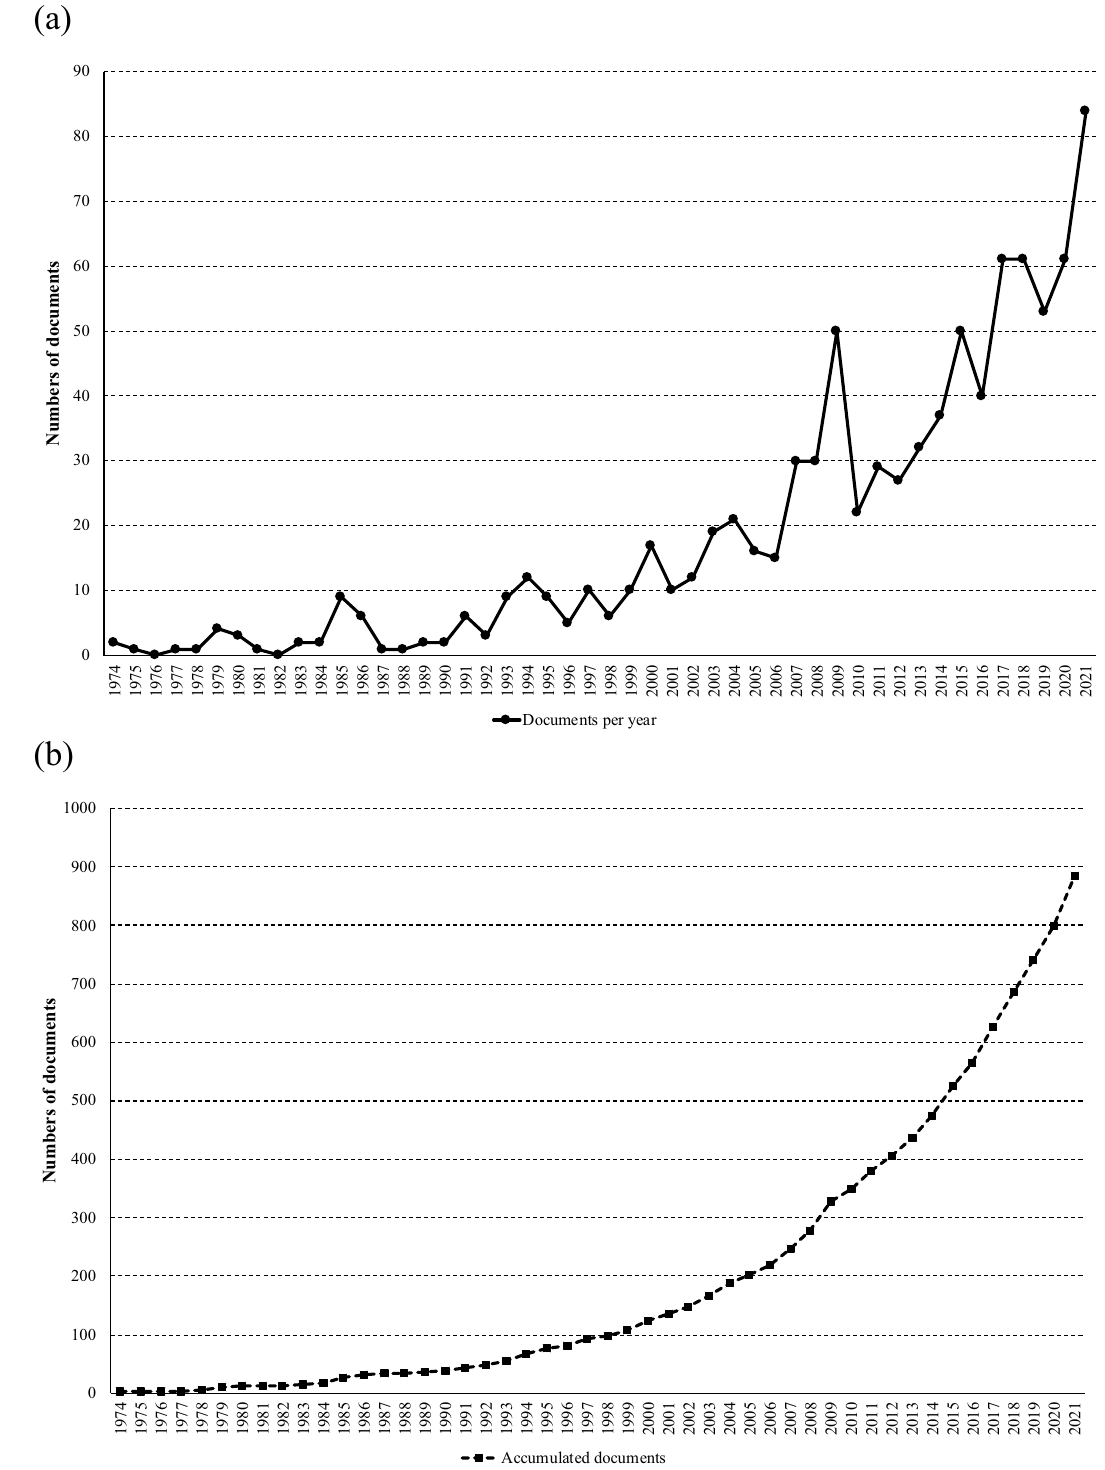
Fig. 2 Number of documents in the horizon-time (1974–2021) ( a ) documents per year; ( b ) Accumulated